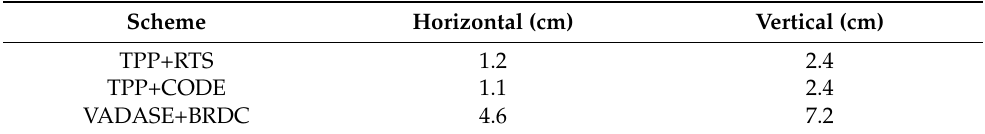
Table 5. The average RMS values of coseismic displacement biases over selected 51 stations for three schemes.